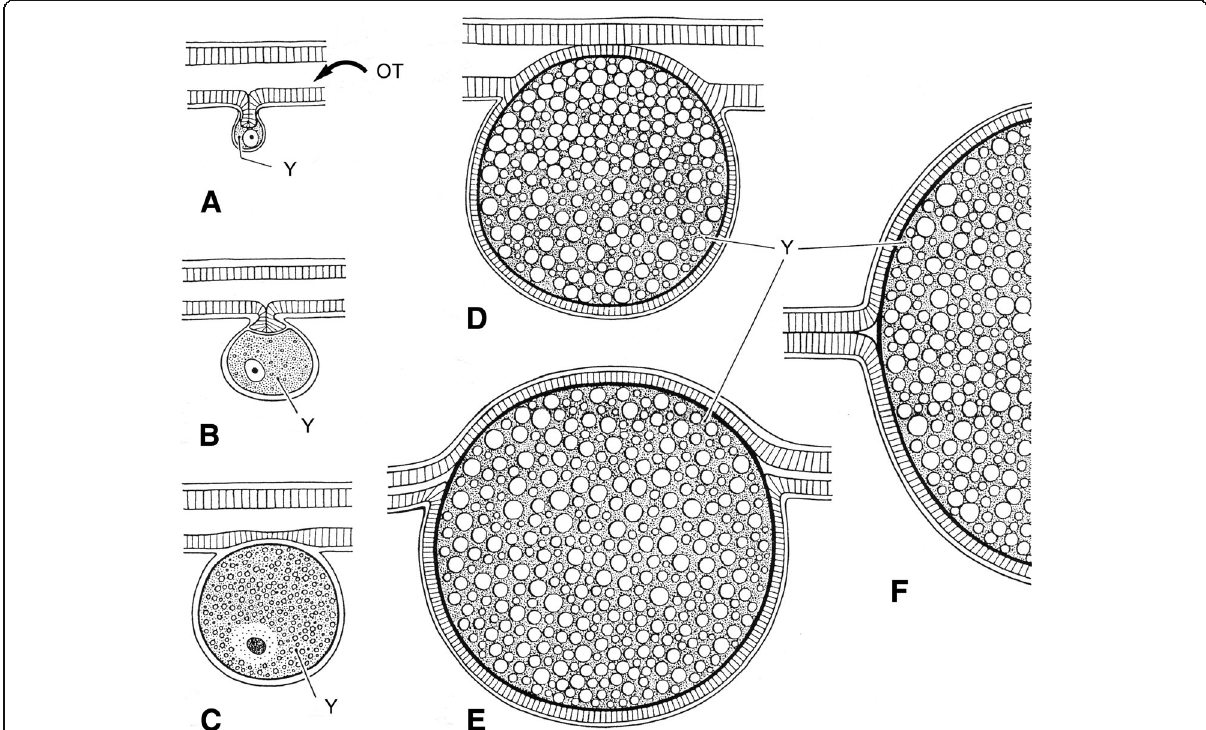
Fig. 3 Schematic embryonic development of a buthid scorpion. ( a-c ) Early development of ovum outside ovariuterine tubule (OT). ( d-f ) Migration to the tubule and development yolk-producing cells of germinative epithelium